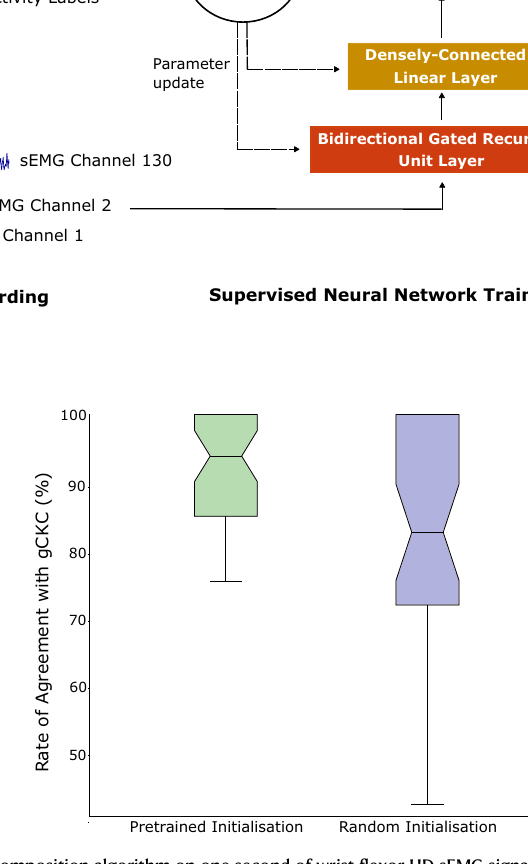
decomposition algorithm on one second of wrist fl exor HD-sEMG signal. Data is presented as median values over 39 motor units from nine participants +/ − the interquartile range on theboundsof the box, withthe lowestand highest valuesas the whiskers. Both outputs were converted to timestamps using a two class K-meansclustering.Theneuralnetworkusingagatedrecurrentunit(GRU)network thatwaspre-trained using simulatedEMG signal signi fi cantly outperformed a GRU with random initialisation (two-tailed Wilcoxon signed-rank test, Z = 4.0, p